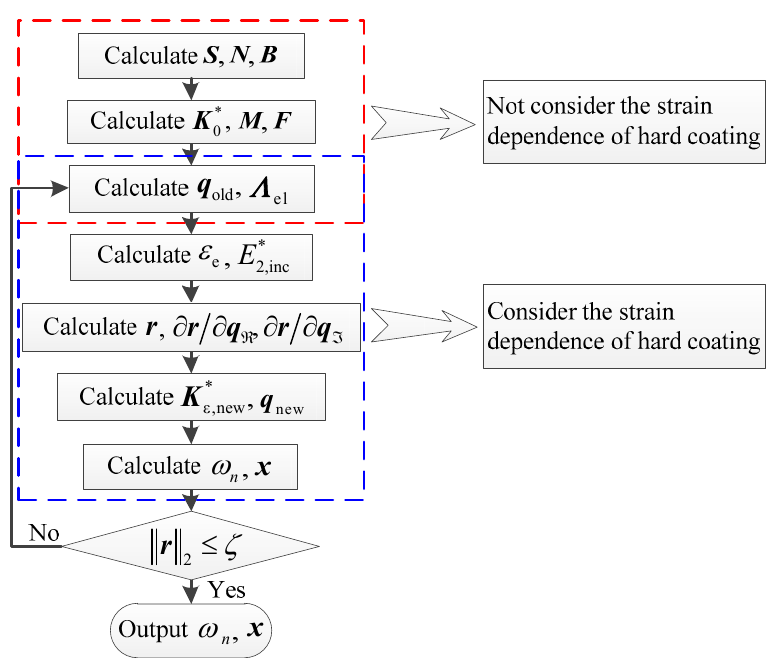
Figure 2. Solution procedure of the nonlinear vibration of the hard-coating cylindrical shell.